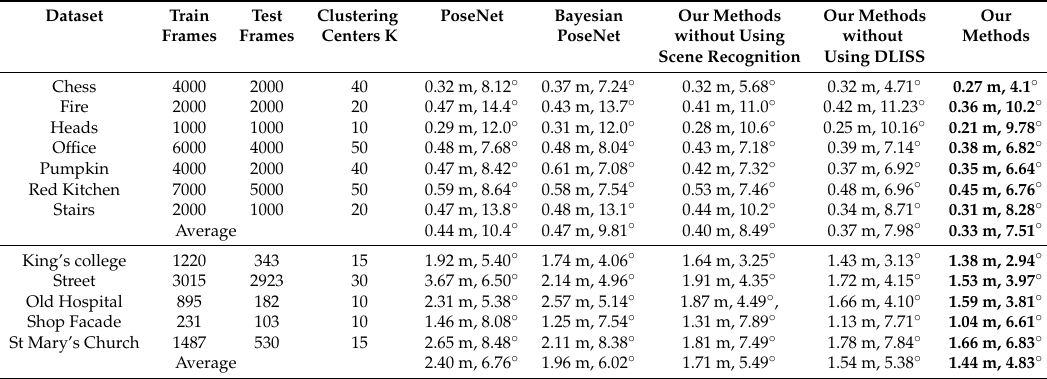
Table 2. Dataset details and results. We can see that our CNN show better performance on all scenes than PoseNet and Bayesian PoseNet. We also can see that the positional error and the angular error are reduced with the scene